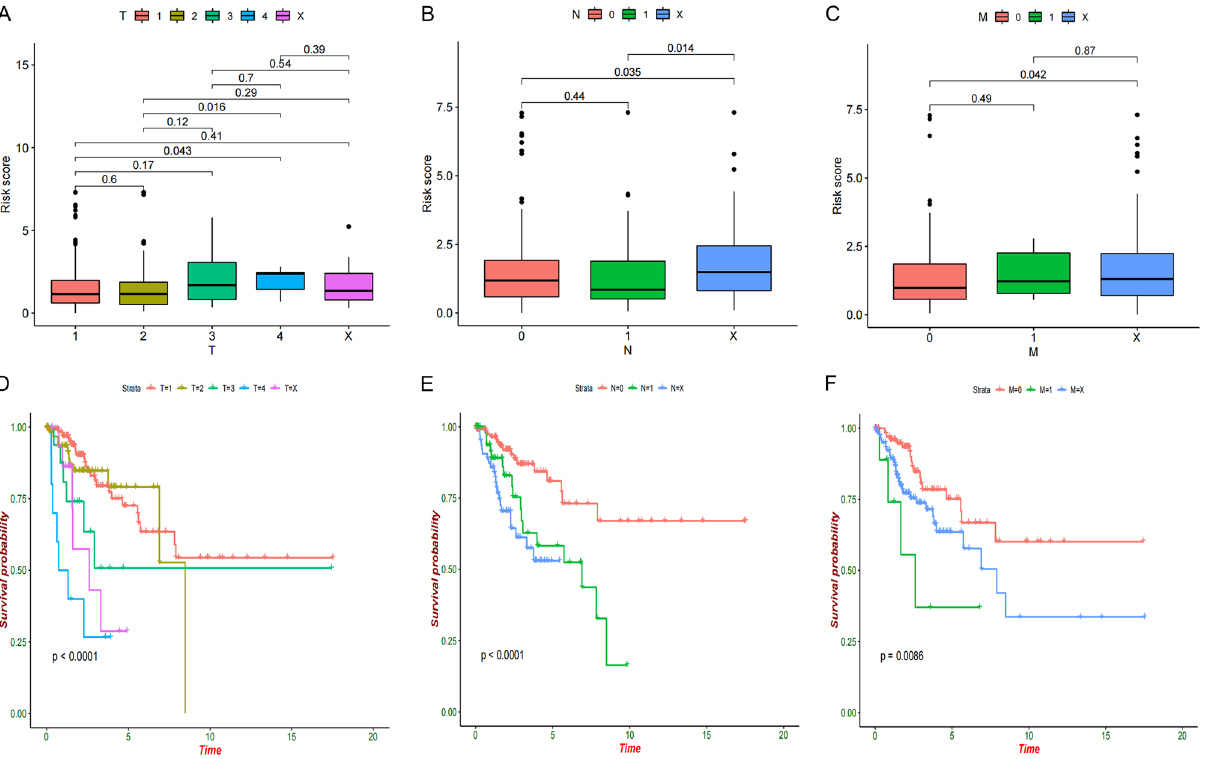
Figure 9. ( A – C ) Distribution of risk scores in TNMpathological stage. ( D – F ) The survival curve of TNM staging